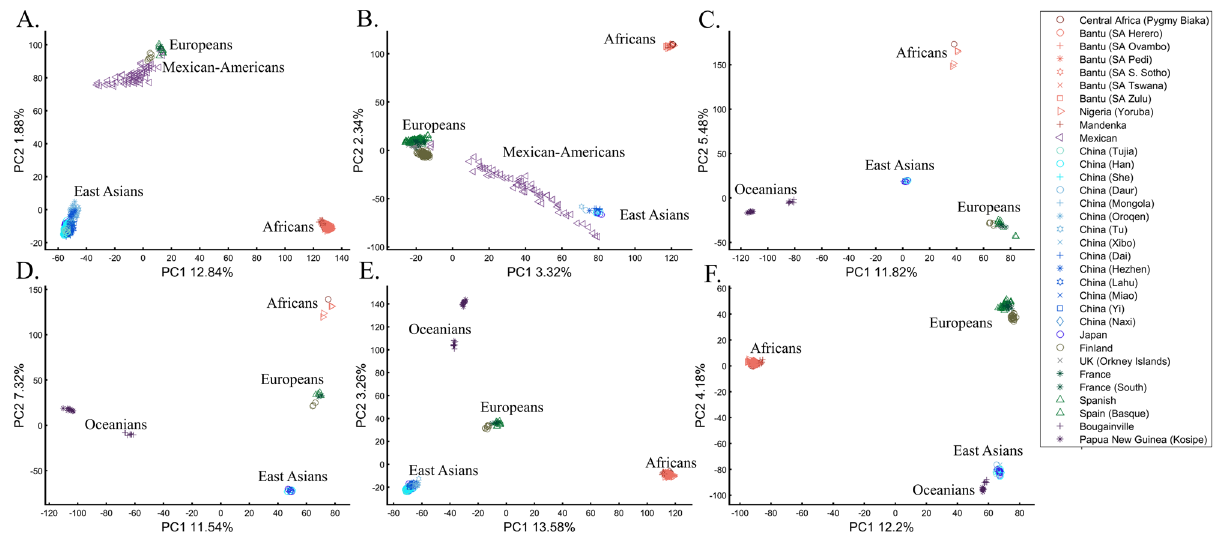
Figure 3. PCA of uneven-sized African (Af), European (Eu), Asian (As), and Mexican-Americans (Ma) or Oceanian (Oc) populations. Fixing the sample size of Mexican-Americans and altering the sample sizes of other populations: ( A ) n Af = 198; n Eu = 20; n As = 483; n Ma = 64 and ( B ) n Af = 20; n Eu = 343; n Ma = 20; n Am = 64 changes the results. An even more dramatic change can be seen when repeating this analysis on Oceanians: ( C ) n Af = 5; n Eu = 25; n As = 10; n Oce = 20 and ( D ) n Afr = 5; n Eu = 10; n As = 15; n Oc = 20 and when altering their sample sizes: ( E ) n Af = 98; n Eu = 25; n As = 150; n Oc = 24 and ( F ) n Af = 98; n Eu = 83; n As = 30; n Oc =